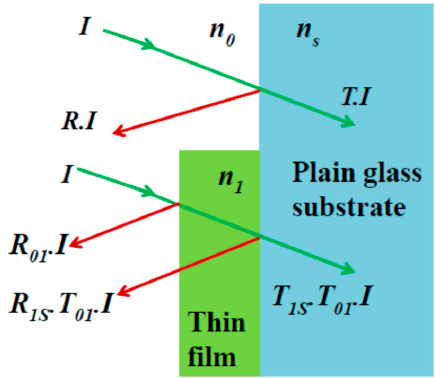
Figure 1. Comparison of light reflection losses on a plain glass substrate (upper portion: sky blue) by using a thin film on the plain glass substrate (lower portion: light green).